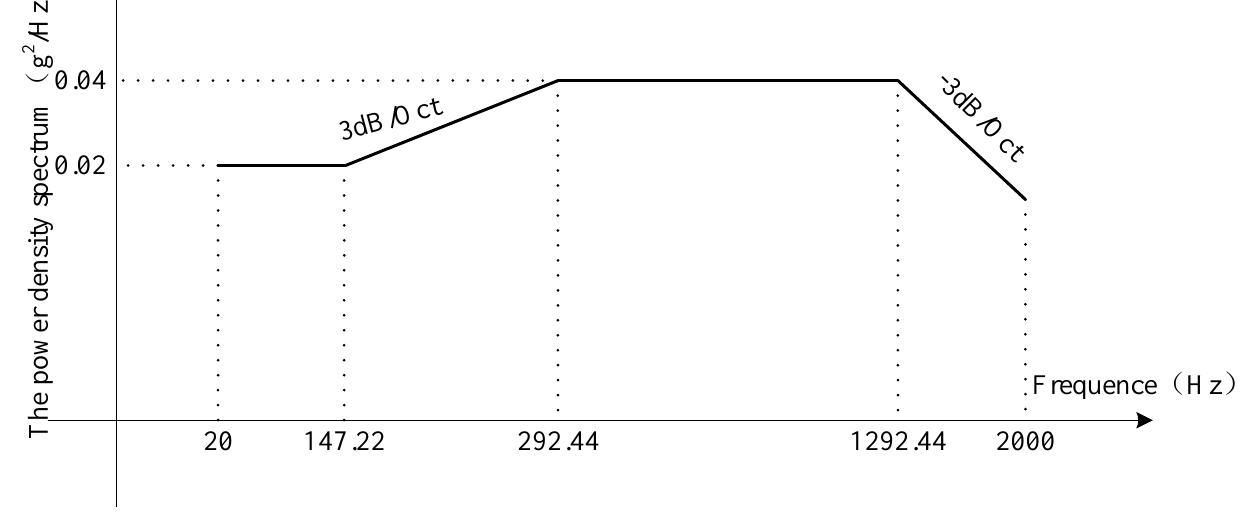
Figure 17. The power density spectrum of random vibration.